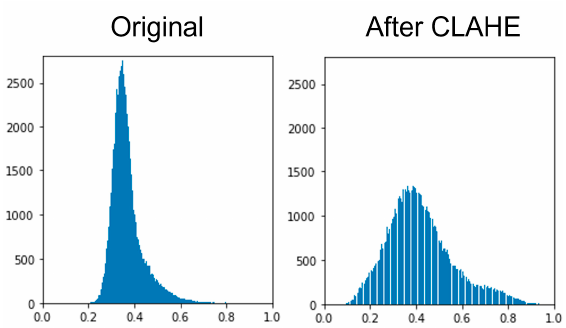
Figure 10. Histogram of a SAR Log Intensity image, before and after applying histogram equalization using CLAHE.